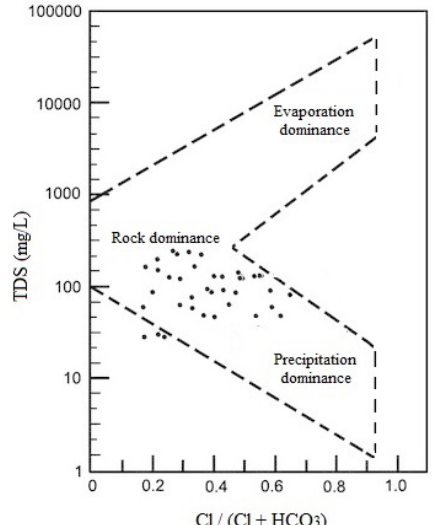
Fig. 5: Gibbs’s diagram representing the ratio of Cl - /(Cl - /HCO 3- ) as a function of TDS Table 2: Pearson’s correlation matrix for physic chemical parameters of lake water samples